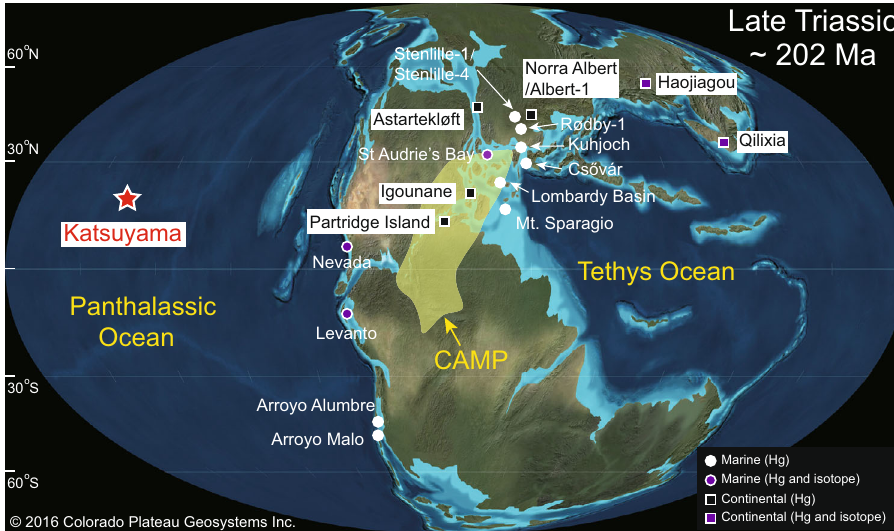
Fig. 1 Late Triassic (~202 Ma) global paleogeography. Geo-map adapted from Ron Blakey https://deeptimemaps.com/, (©2016 Colorado Plateau Geosystems Inc.) Red star shows the study site (Katsuyama section), located in the center of Panthalassa. Circles and squares represent other marine and continental sections, respectively, for which mercury data have been generated, including Hg concentrations and isotopes for Nevada 17,18 , St Audrie ’ s Bay 14,18 , Levanto 18 , Haojiagou, and Qilixia 19 ; Hg concentrations for Arroyo Malo, Astartekløft, Igounane, Kuhjoch, Partridge Island (from ref. 14 ); Stenlille-1/ Stenlille-4, Rødby-1, and Norra Albert/Albert-1 (from ref. 26 ), Cs ő vár (from ref. 27 ), Arroyo Alumbre (from ref. 11 ), as well as Lombardy Basin, and Mt. Sparagio (from ref. 18 ).